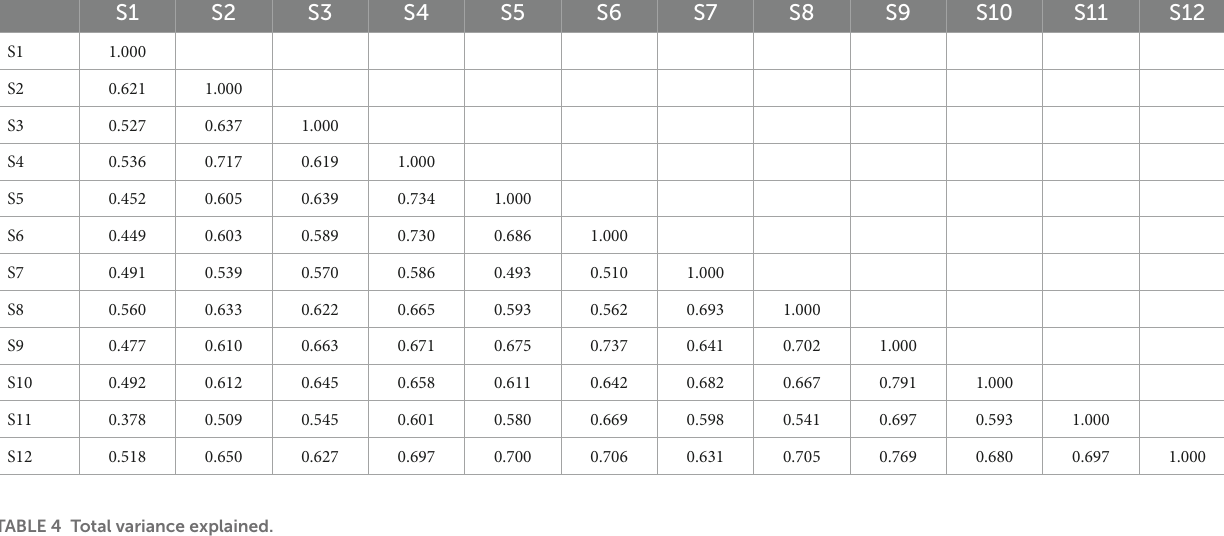
TABLE 4 Total variance